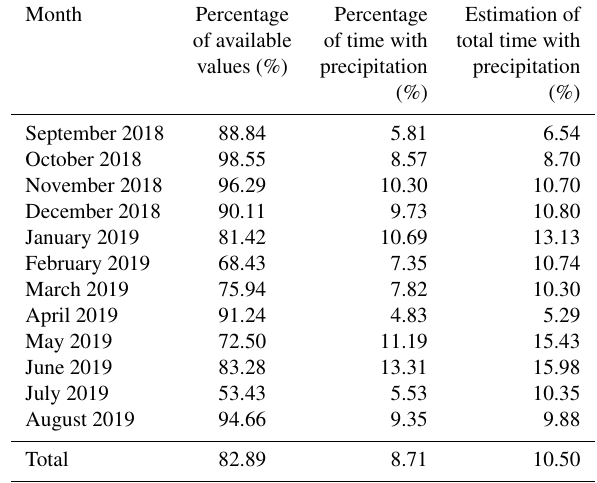
Table 1. Percentage of available data for each month. Table 2. Precipitation intensity distribution for seasons and inten- sity